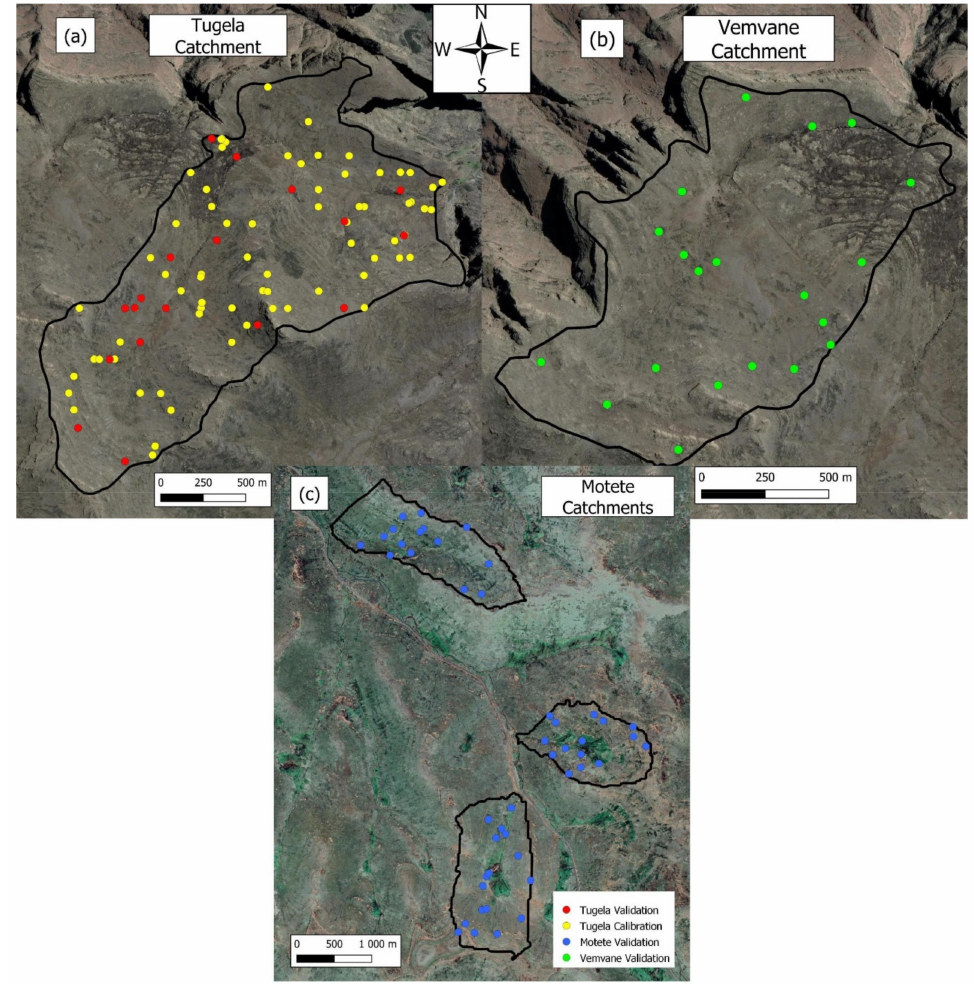
Figure 2. The locations from where samples were collected. ( a ) Tugela catchment with its calibration and validation samples, ( b ) the Vemvane catchment with only validation samples, and ( c ) the Motete catchments with validation samples from each of the